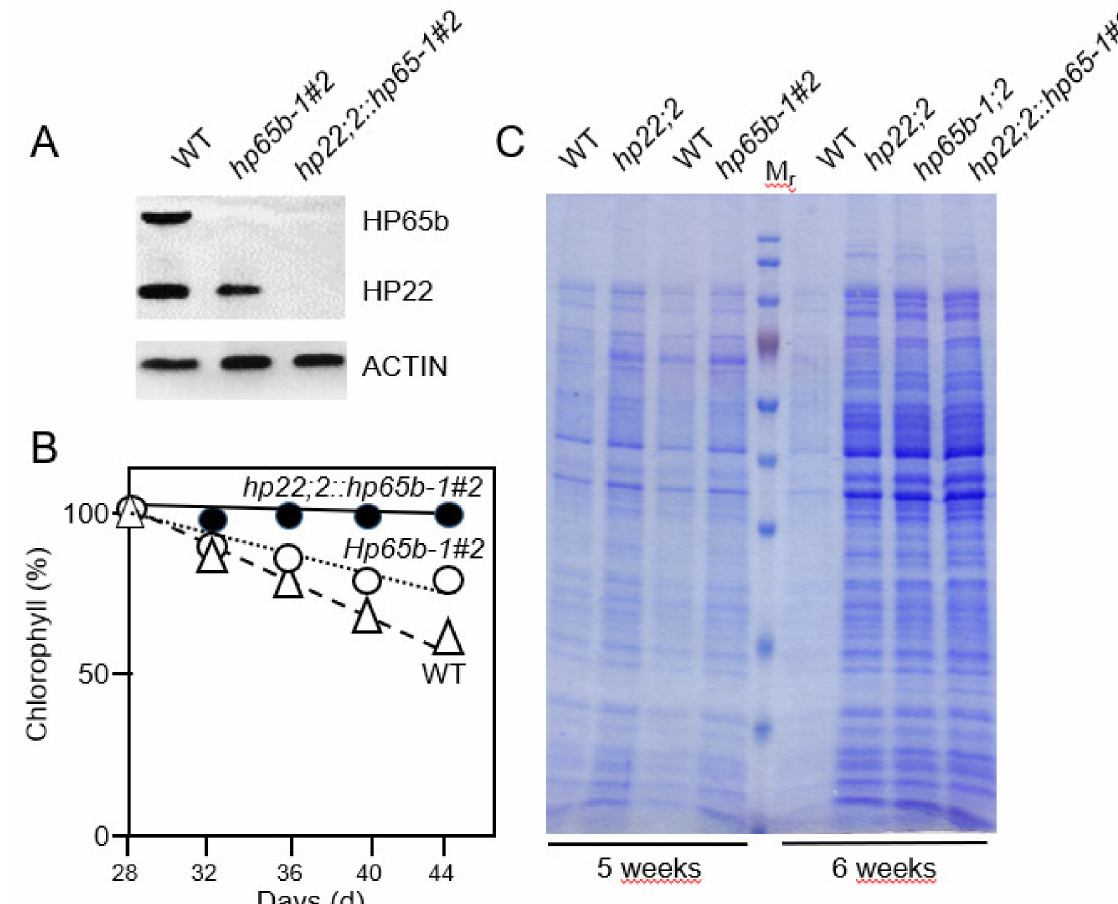
Figure 7. Genetic interaction of HP65b with HP22 during leaf senescence. ( A ) Protein gel blot analysis to demonstrate the lack of HP65b in the generated RNAi line Athp65b-RNAi-1#2 (cf. Figure S19 and S20) and respective cross with Athp22;2 (Athp22;2::Athp65b-RNAi-1#2) versus the wild-type. For comparison, replicate blots were probed with antibodies against HP22 and ACTIN. ( B ) Time course of the decay of chlorophyll in Athp65b-RNAi-1#2 , Athp22;2::Athp65b-RNAi-1#2 and wild-type plants undergoing leaf senescence. ( C ) Patterns of Coomassie-stained total chloroplast proteins on an equal plastid number basis in 5- and 6-weeeks-old Arabidopsis plants. Note the severe delay in chloroplast protein loss in Athp65b–RNAi1#2 and Athp22;2::Athp65b-RNAi-1#2 versus wild-type